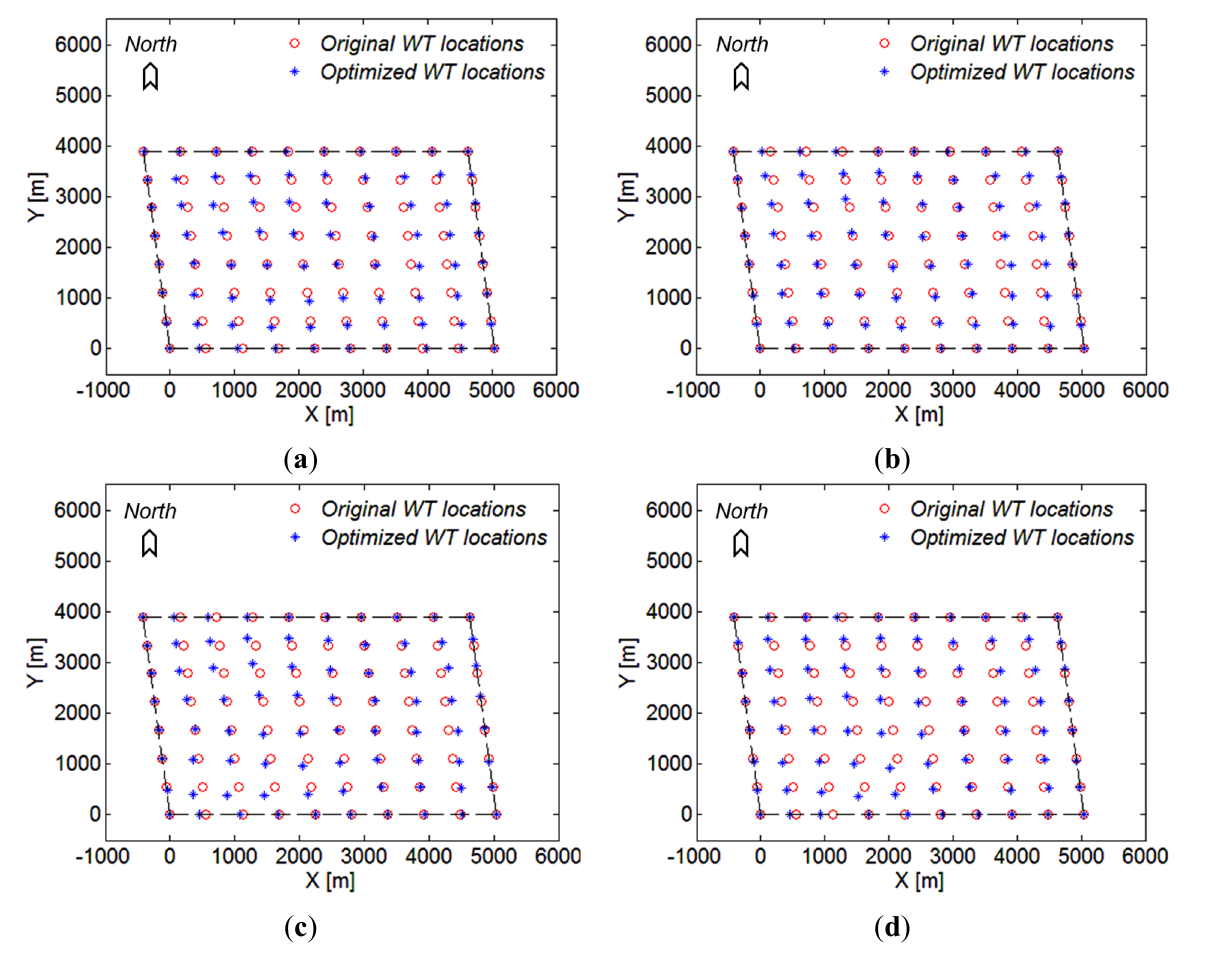
Figure 11. Optimized layouts of the Horns Rev 1 WF by using the spline joint distribution in wind modelling and choosing ( a ) bs-5: (cid:1986)(cid:1874) (cid:3404) 2 m/s , (cid:1986)(cid:2016) (cid:3404) 1° ; ( b ) bs-6: (cid:1986)(cid:1874) (cid:3404) 1 m/s , (cid:1986)(cid:2016) (cid:3404) 1° ; ( c ) bs-7: (cid:1986)(cid:1874) (cid:3404) 0.5 m/s , (cid:1986)(cid:2016) (cid:3404) 1° ; ( d ) bs-8: (cid:1986)(cid:1874) (cid:3404) 0.1 m/s , (cid:1986)(cid:2016) (cid:3404) 1° in